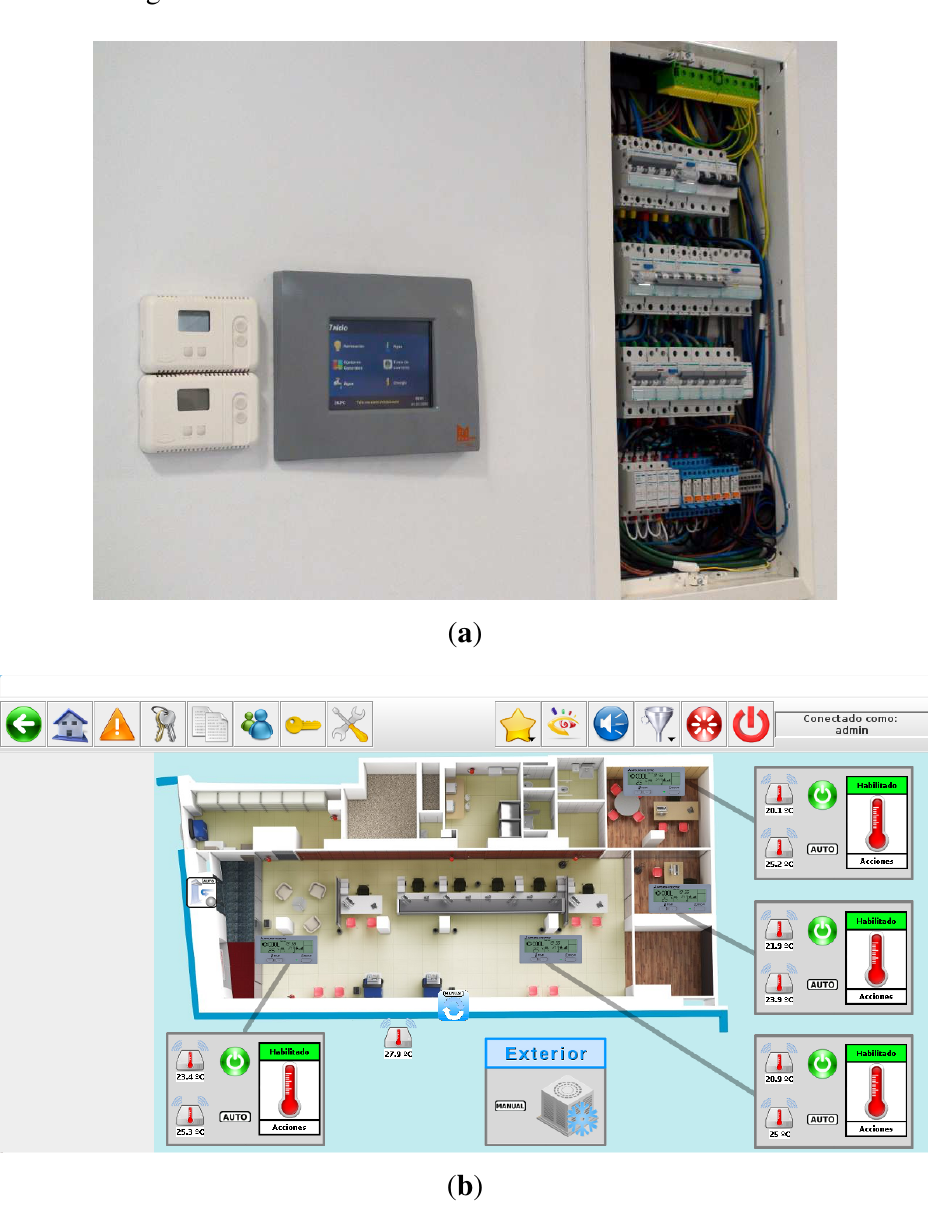
Figure 8. Control panel prototype. ( a ) Control panel installed in the reference building; ( b ) HMI of the integrated